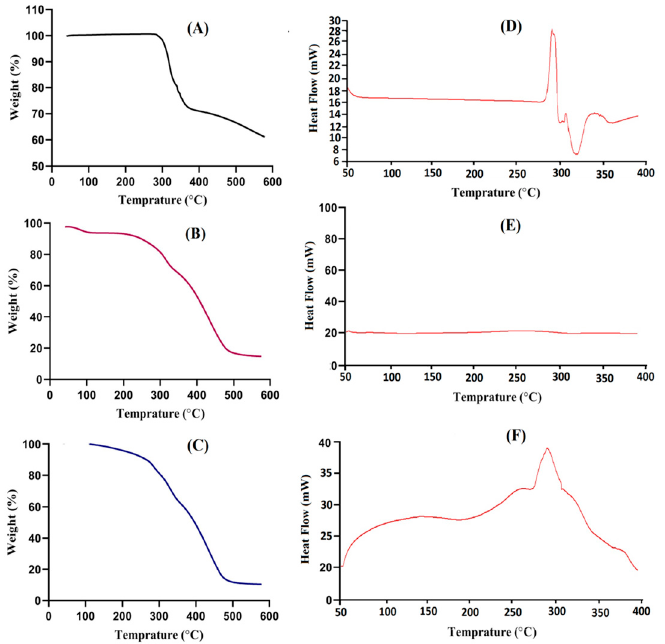
Figure 3. TGA of ( A ) DS, ( B ) carbopol and ( C ) Car934-g-poly(acrylic acid) hydrogel. DSC of ( D ) DS, ( E ) carbopol and ( F ) Car934-g-poly(acrylic acid) hydrogel.